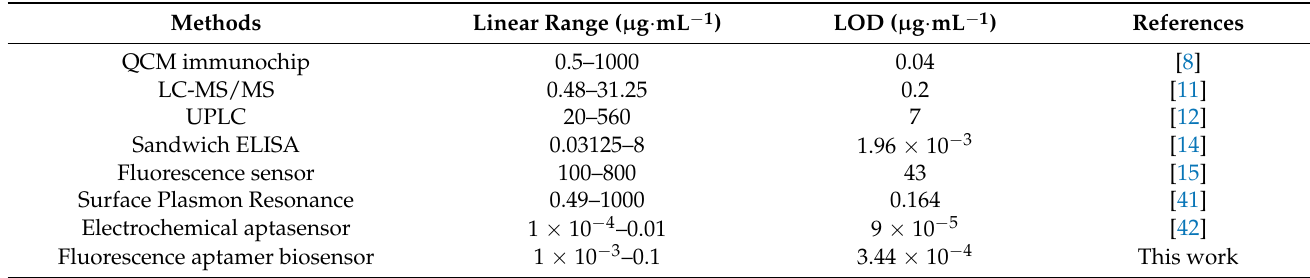
Figure 5. ( a ) Fluorescence emission spectra of β -Lg aptamer at various concentrations of β -Lg (from a to i: 0, 0.1, 0.5, 1, 10, 20, 50, 100, and 150 µ g · mL − 1 ). ( b ) The standard curve of β -Lg. Insert: linear fitting of fluorescence intensity versus target β -Lg concentration at 518 nm. Table 1. Comparison of different β -Lg assays.